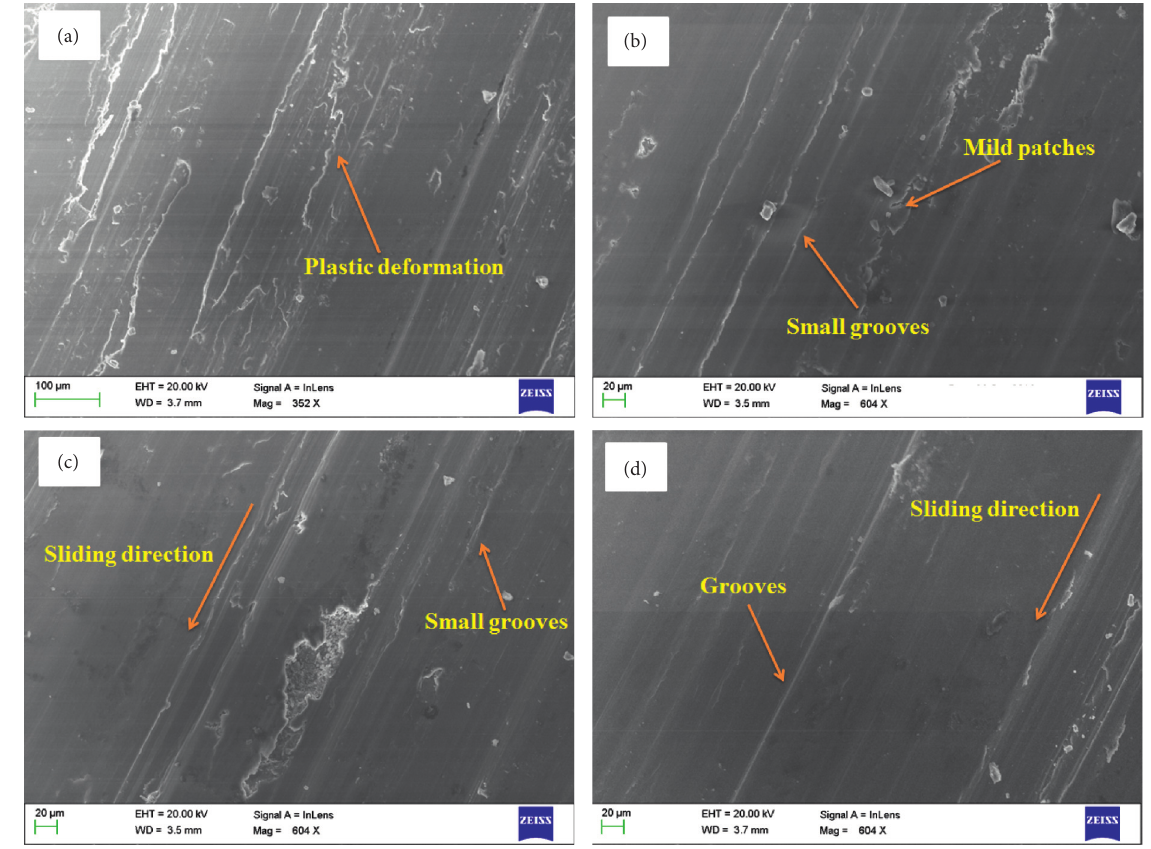
Figure 11: SEM micrographs of the worn surface of (a) 0wt% TiB